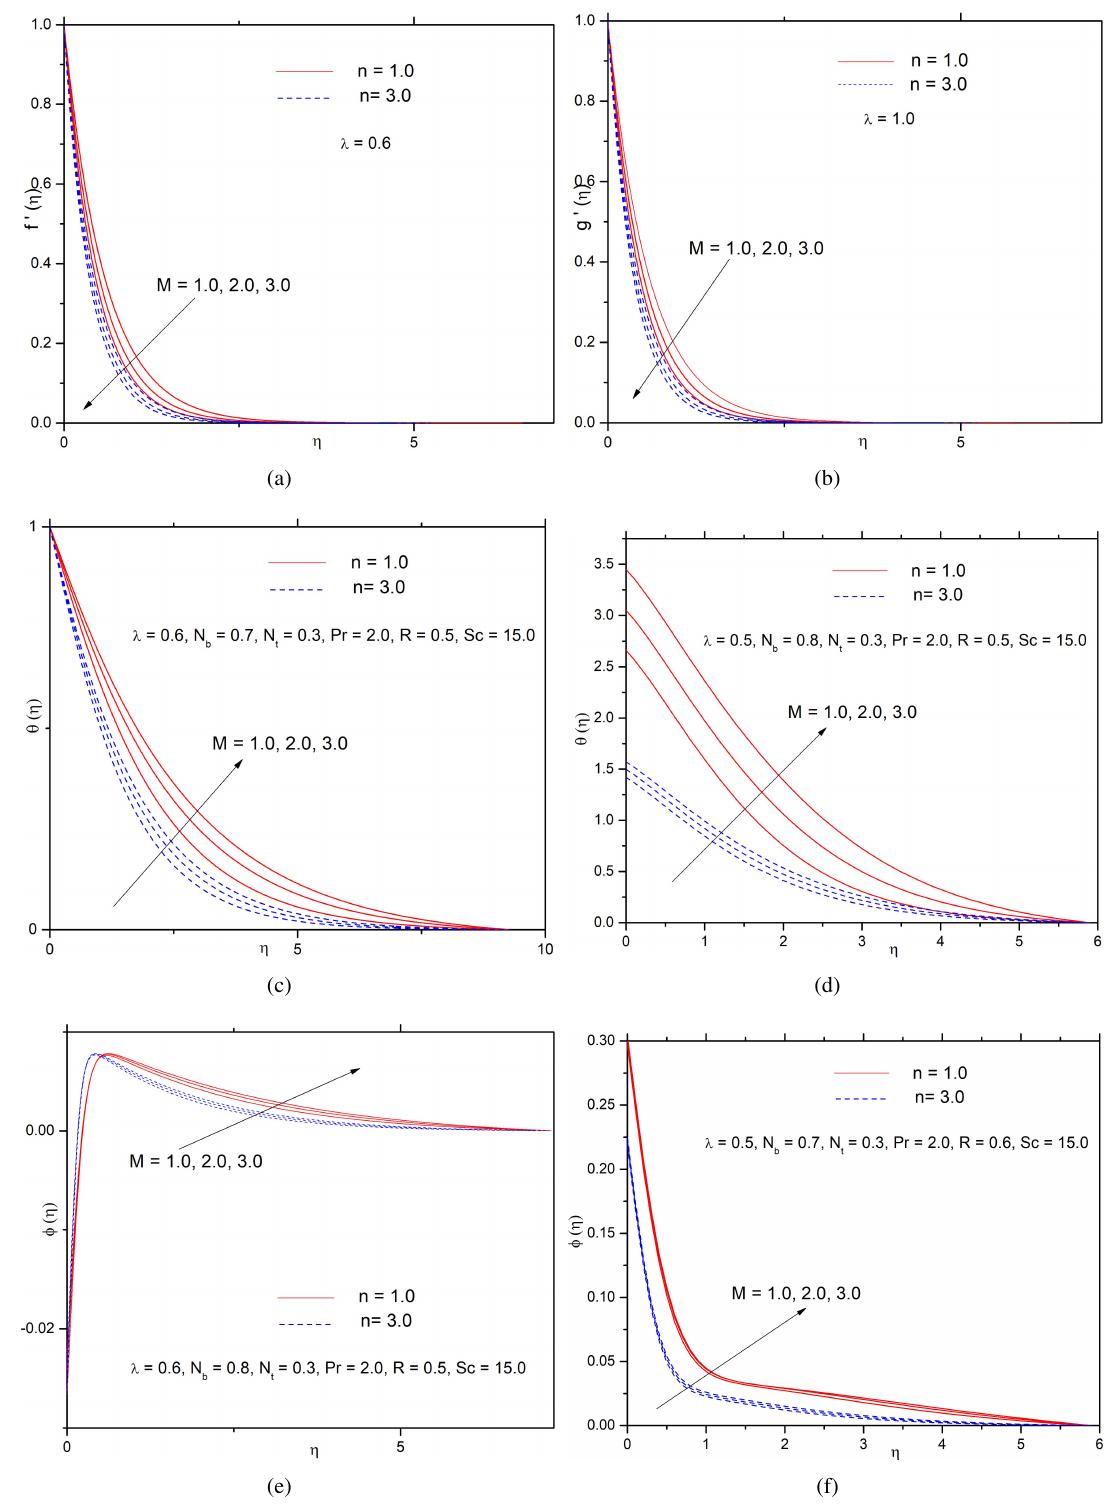
Fig. 2 Influences of magnetic parameter M on (a) f (cid:48) ( η ) , velocity in the direction of x (b) g (cid:48) ( η ) , velocity in the direction of y , temperature θ ( η ) for (c) CWT (d) PHF and nanoparticle volume fraction ϕ ( η ) for (e) ZMF and (f)